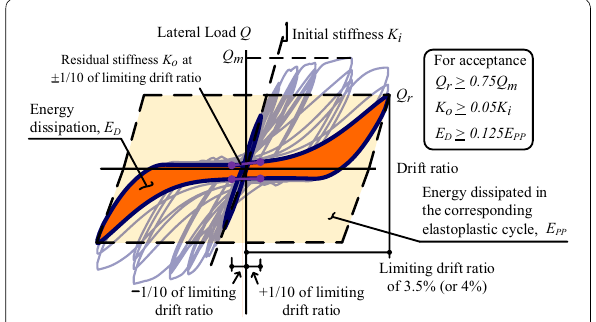
Fig. 4 Acceptance criteria for testing components of special moment frames given by ACI